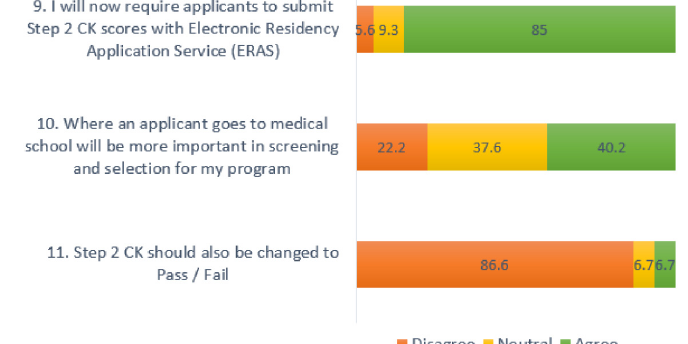
Figure 2. How program directors plan to adjust their applicant screening process. CK, clinical